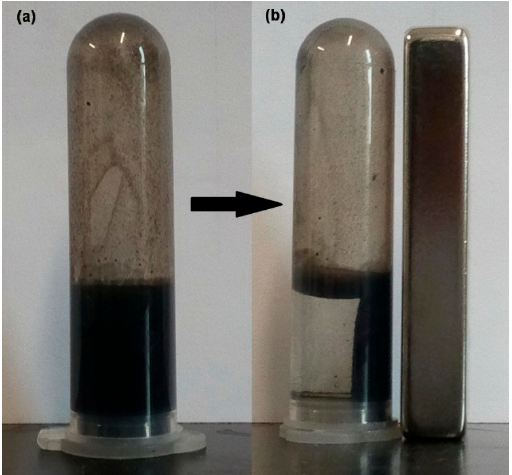
Figure 4. ( a ) Image of Au-SiO 2 @Fe 3 O 4 -RGO suspension before the reaction. ( b ) Image of the reaction system with an additional magnet on the side after the reaction.